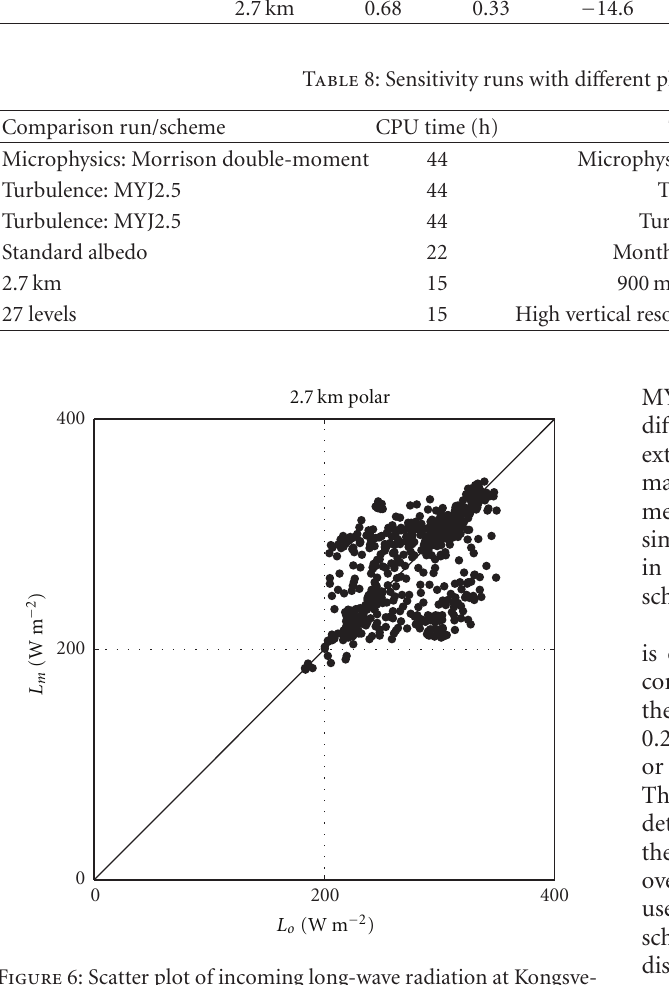
Figure 6: Scatter plot of incoming long-wave radiation at Kongsve- gen in summer 2009 for 2.7 km